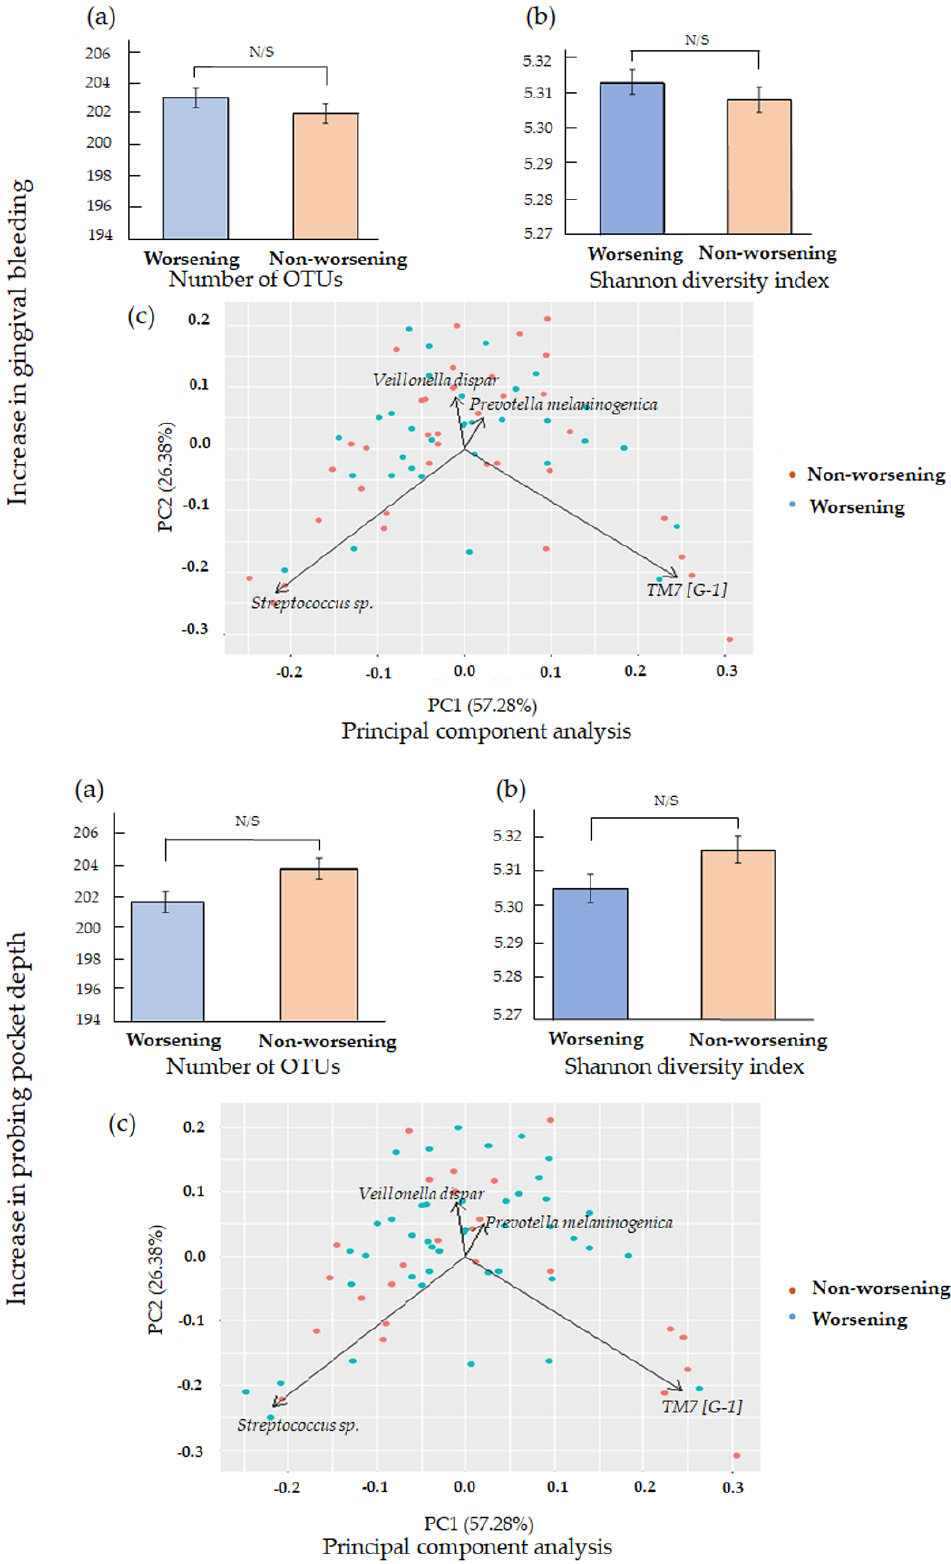
Figure 2. ( a ) Mean number of operational taxonomic units (OTUs); ( b ) Shannon diversity index values and ( c ) Principal component analysis (PCA) of 69 participants (increase in gingival bleeding and increase in probing pocket depth (PPD)). There were no significant di ff erences in the number of OTUs, Shannon diversity index values, and PCA between the worsening and non-worsening